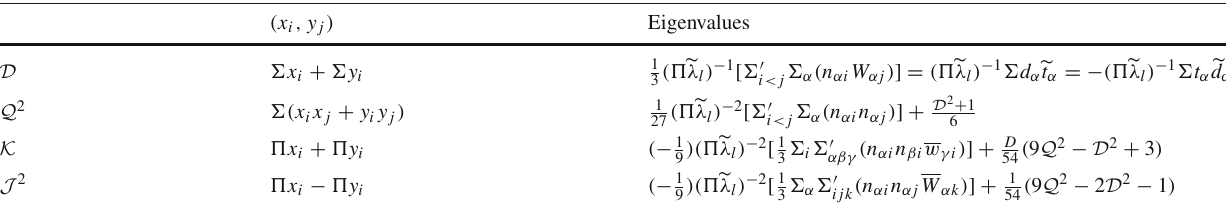
Table 2 Expressions for ( D , Q 2 , K , J 2 ) in terms of ( x i , y j ) and the